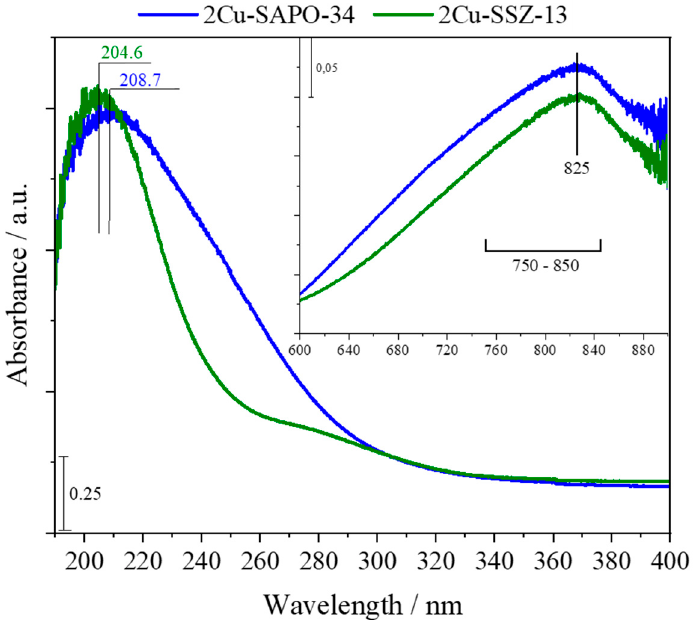
Figure 3. HR-TEM images and EDX mapping of the Cu-containing zeolites ( a ) 2Cu-SAPO-34 and ( b ) 2Cu-SSZ-13.